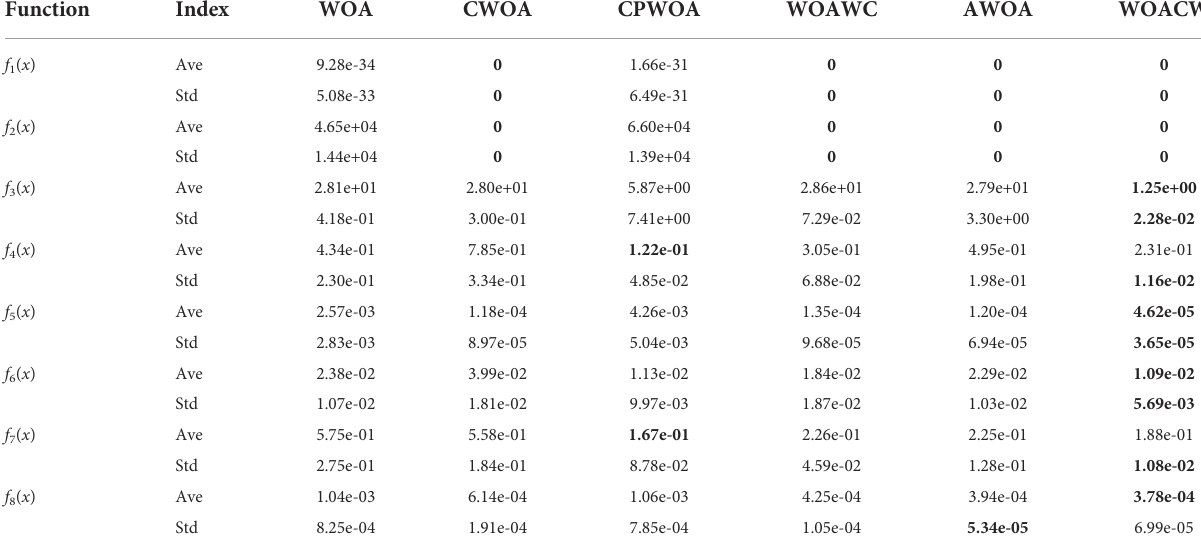
TABLE 4 Performance comparison of eight